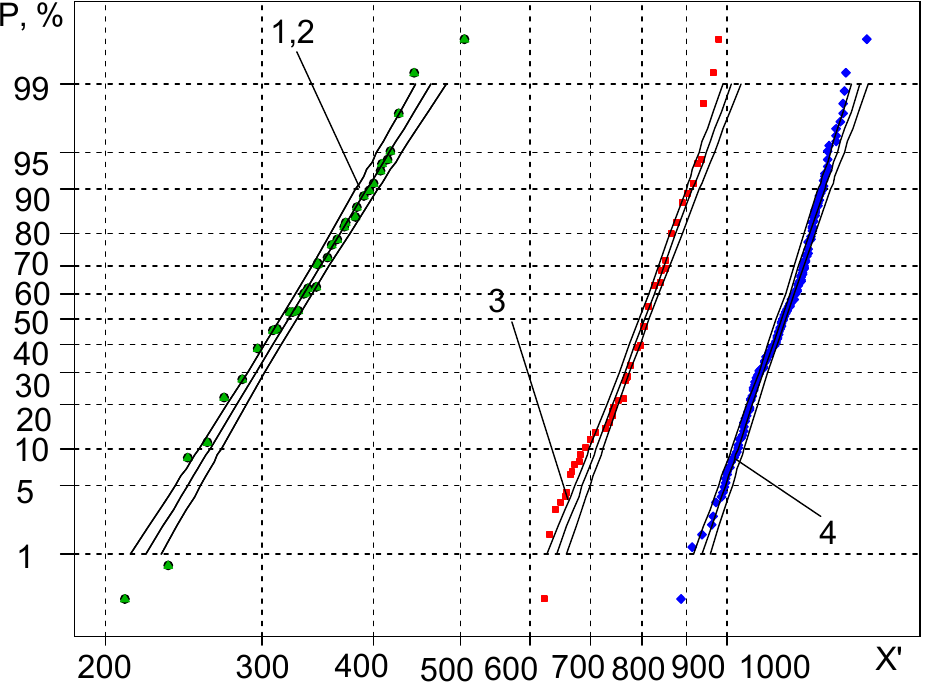
Figure 10. Statistical distribution curves for the mechanical properties of steel C45 without adjusting for the sensitivity thresholds N 0 and N k (1— σ y , 2— σ pr , 3— σ u , 4— S k